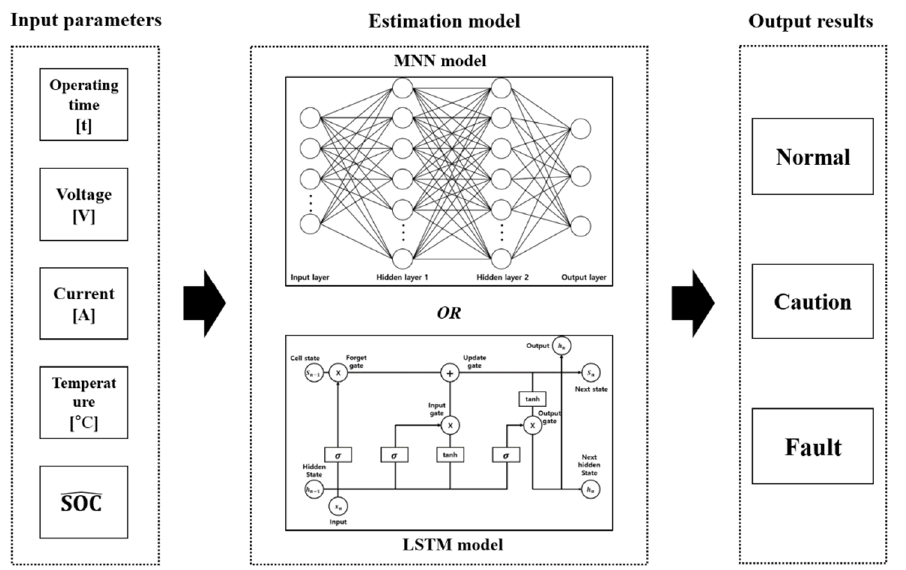
Figure 3. Structure of SOH estimation method.